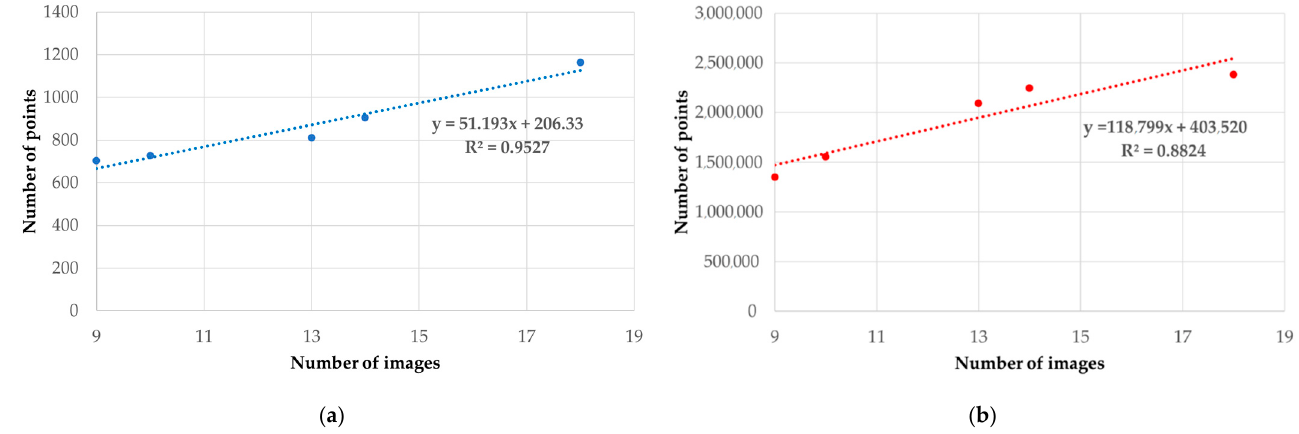
Figure 4. Influence of the number of images in the photogrammetric process versus tie point ( a ) and versus dense cloud ( b ).